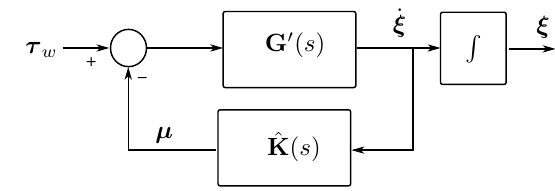
Figure 1: Block diagram of the the Cummins Equation in terms of parametric transfer functions.